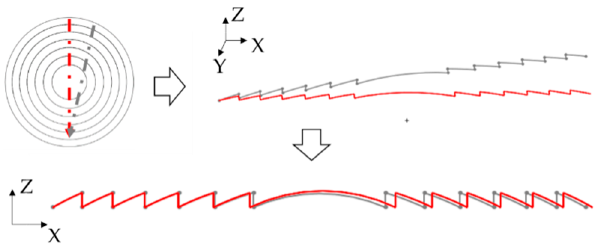
Figure 10. Error analysis of the measurement path.